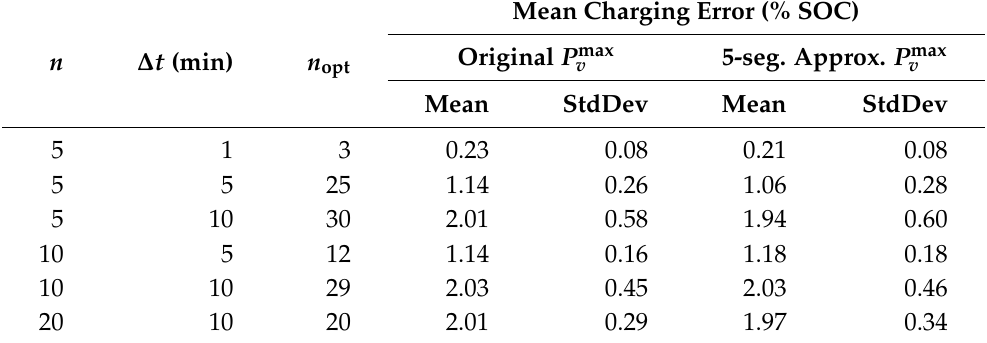
Table 8. Charging error comparison when scheduling with E max-ex v using EVS-SOC-GLIN and realizing the schedule with E max-lb v ; P gridmax = 40 n